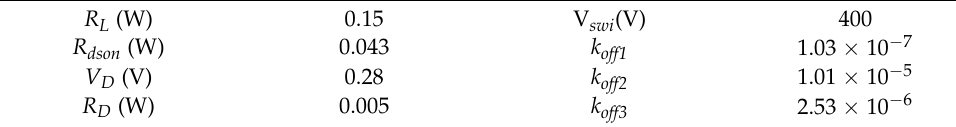
Table 2. Parameters used for loss calculation.